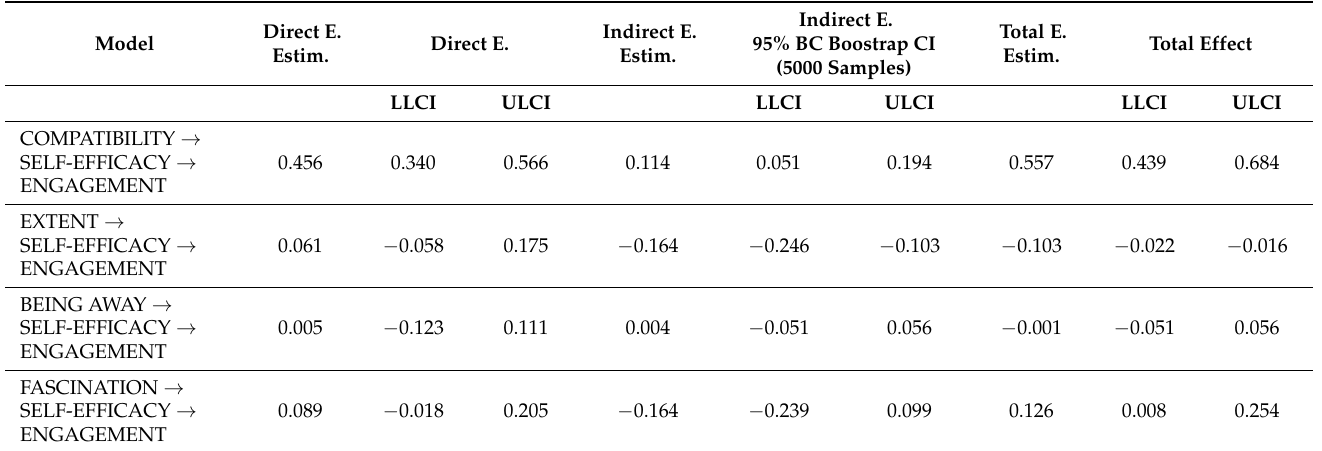
Table 4. Direct and indirect effects of fascination, extent, being away and compatibility on engagement through self-efficacy, and total